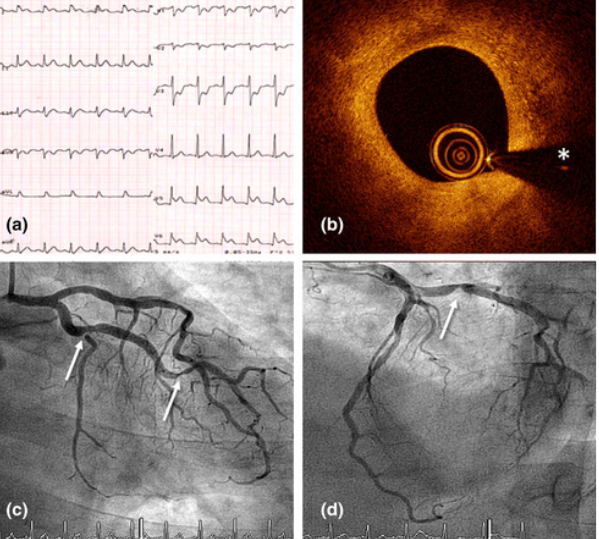
Figure 10. ( a ) An electrocardiogram shows inferolateral ST ‐ segment elevation and specular decline in right precordial leads during a chest pain episode; ( b ) an intracoronary OCT image of the proximal left circumflex coronary artery (LCX) shows a stable fibrous plaque with a minimal lumen area. Erosion or rupture as an ACS cause was ruled out (asterisk denotes wire artifact). (c,d ) Urgent coronary angiography demonstrating proximal and distal LCX lesions [144].